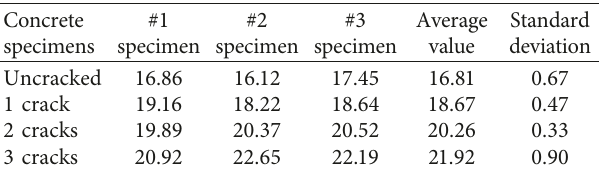
Table 3: Chloride penetrate depth ( X ) in the concrete specimens (mm).